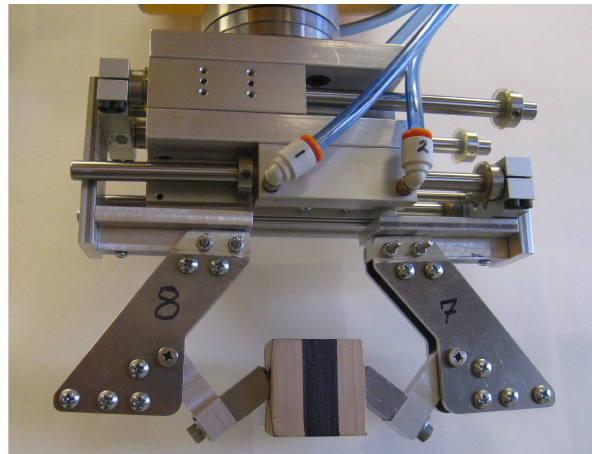
Figure 4. Prototype of parallel jaw gripper with changing